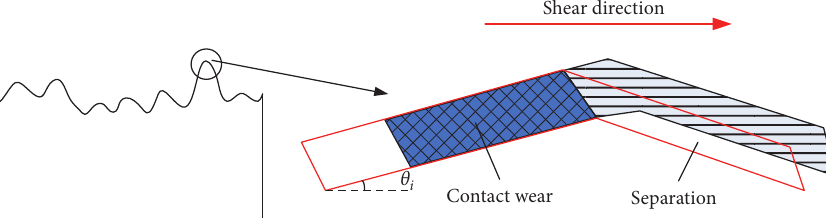
Figure 11: Shear schematic of the joint